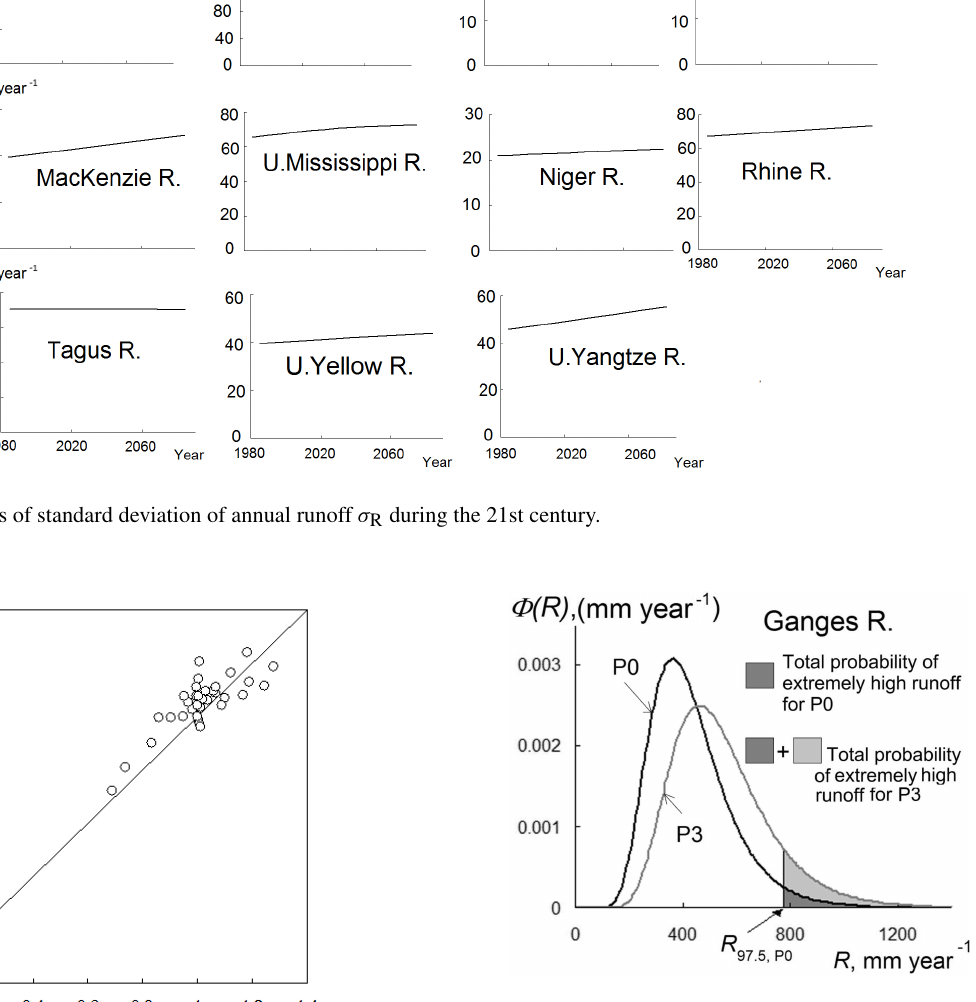
Figure 6. Probability density (cid:56) of annual runoff R for the Ganges River for the historical P0 and prognostic P3 periods. R 97 . 5 , P0 is the quantile of 97.5% probability for the period P0 (the cut point for the extremely high